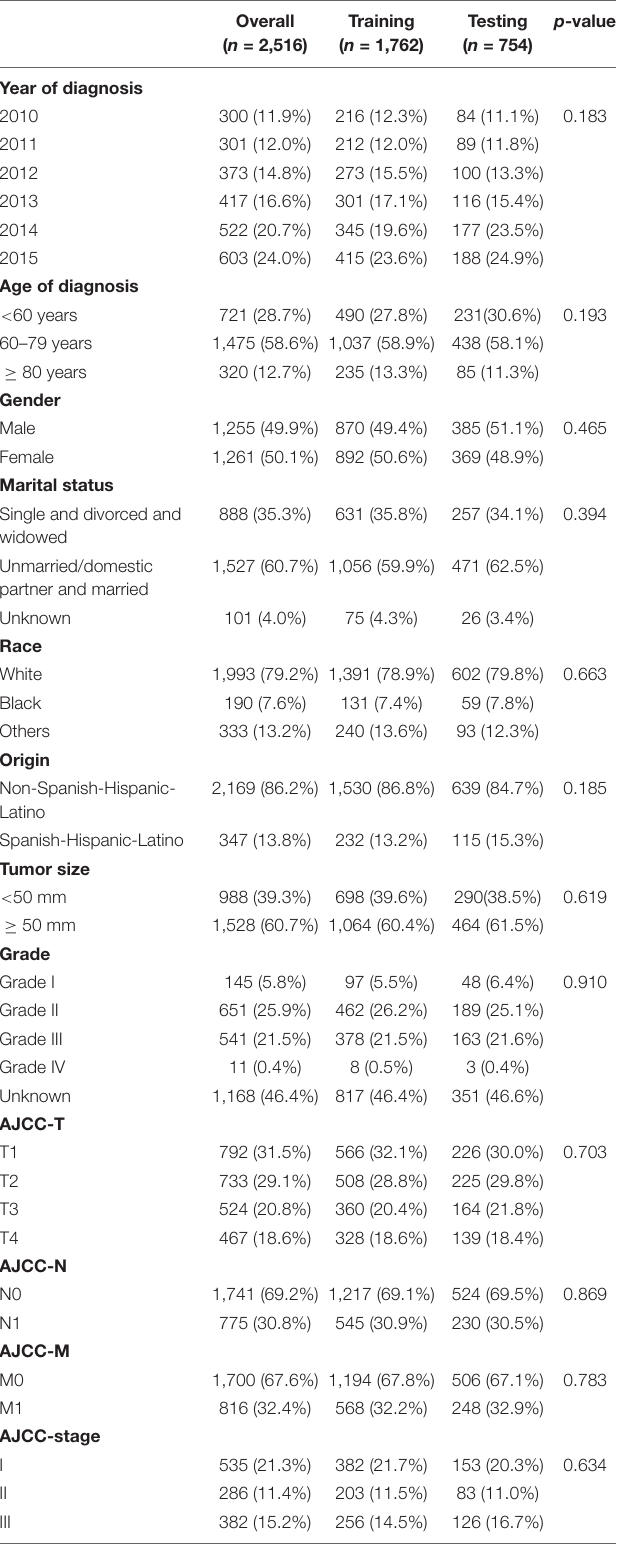
TABLE 1 | Demographic and clinicopathological characteristics of patients with ICCA.